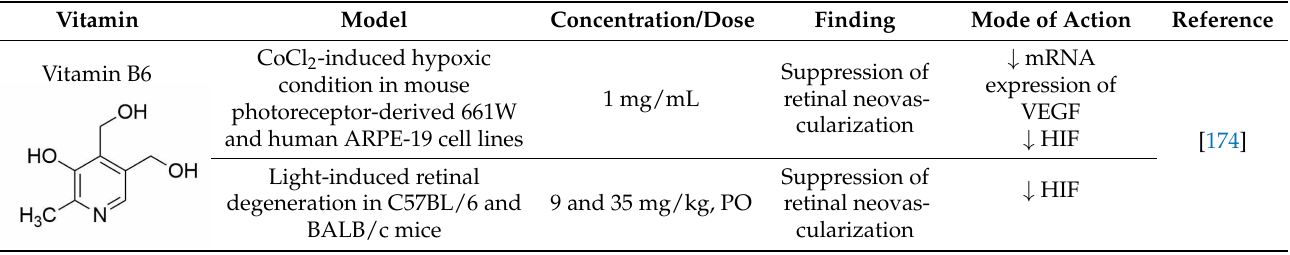
Table 6. Vitamin in the alleviation of